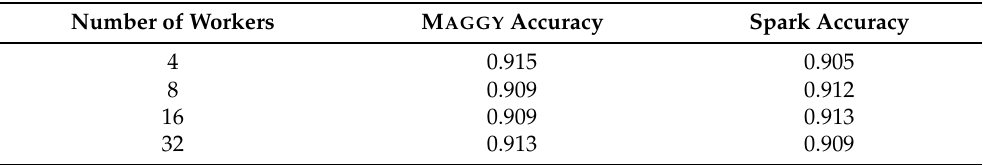
Table 1. The final accuracies of the M AGGY framework and Spark after 100 trials [4]. Number of Workers M AGGY Accuracy Spark Accuracy